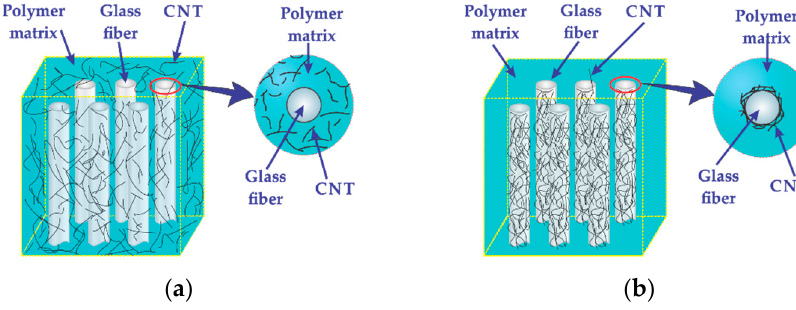
Figure 1. Hierarchical composite architectures. ( a ) Composite architecture m , with MWCNTs dispersed within the matrix, and ( b ) composite architecture f , with MWCNTs deposited onto the fibers.